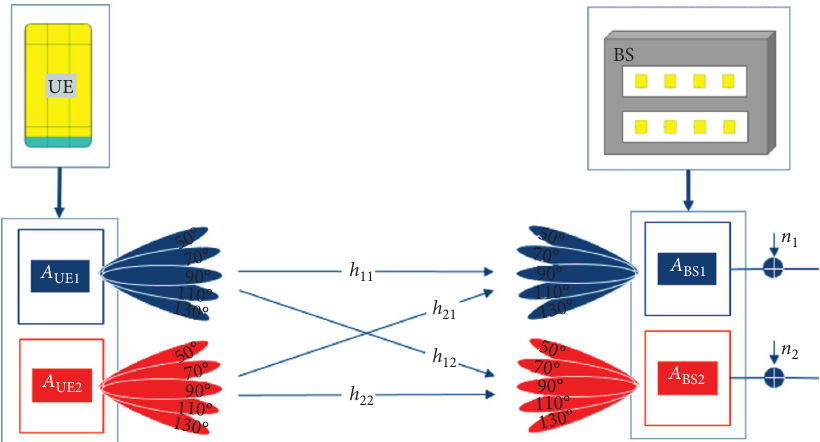
Figure 15: Schematic view of idealized MIMO+beamforming system for the simulator.